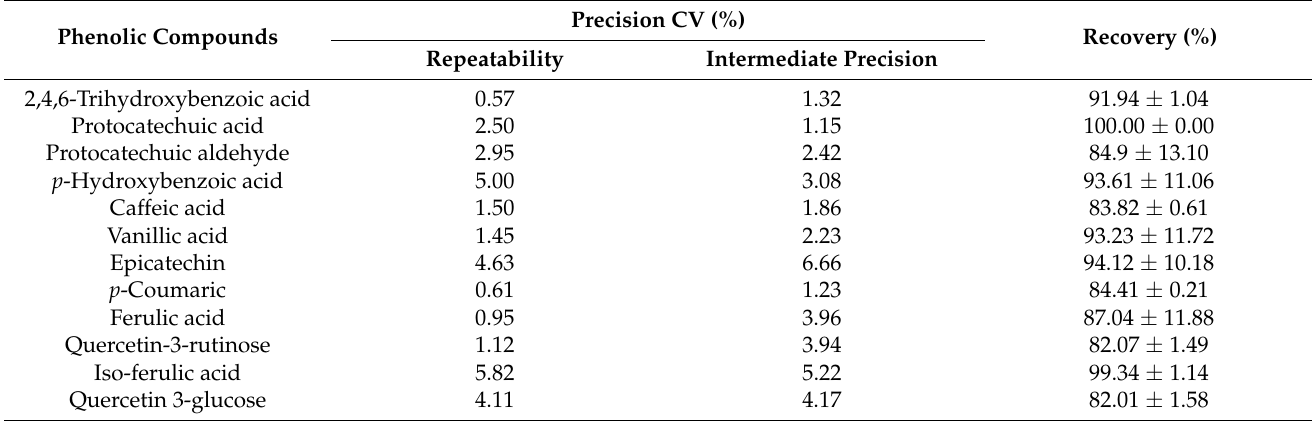
Table 3. Precision and accuracy of UAE for phenolic compounds from dried edible